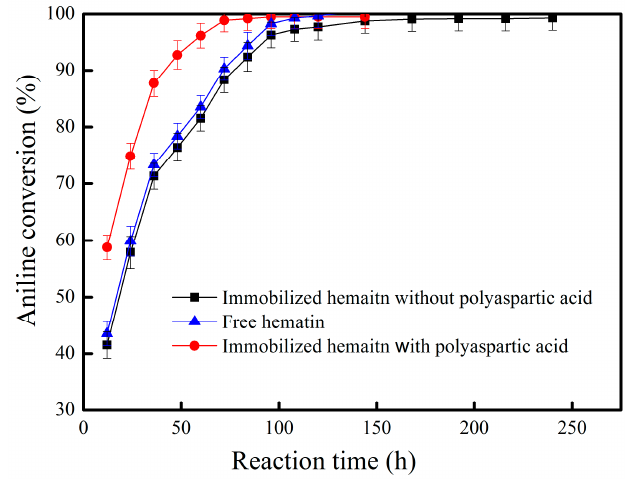
Figure 6. Aniline conversion with reaction time.